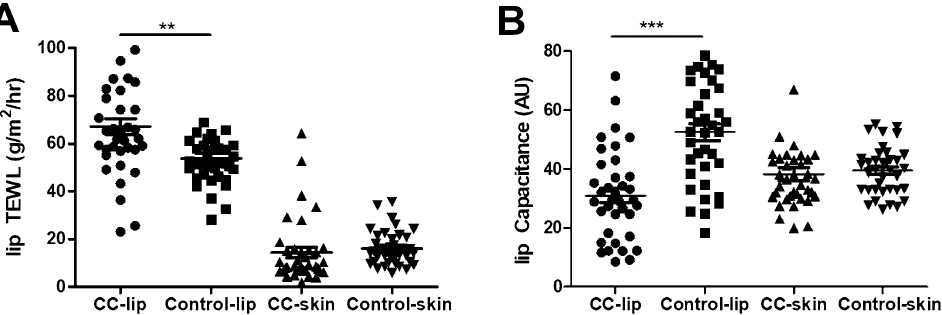
Figure 2. The biophysical parameter values in chronic cheilitis patients. ( A ) TEWL values in the lip and forearm of CC patients and control individuals, ( B ) capacitance values in the lip and forearm of CC patients and control individuals. CC chronic cheilitis, TEWL transepidermal water loss; ** P < 0.01, *** P <